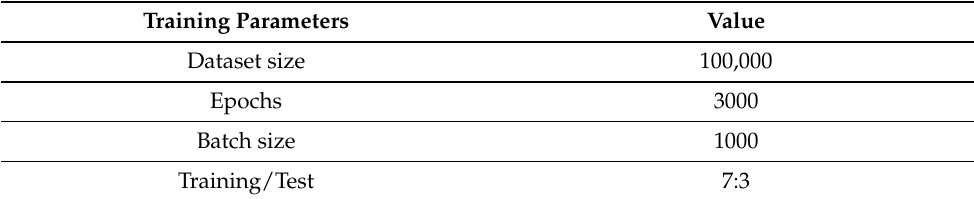
Table 3. Parameters used to train the task scheduling switcher model.